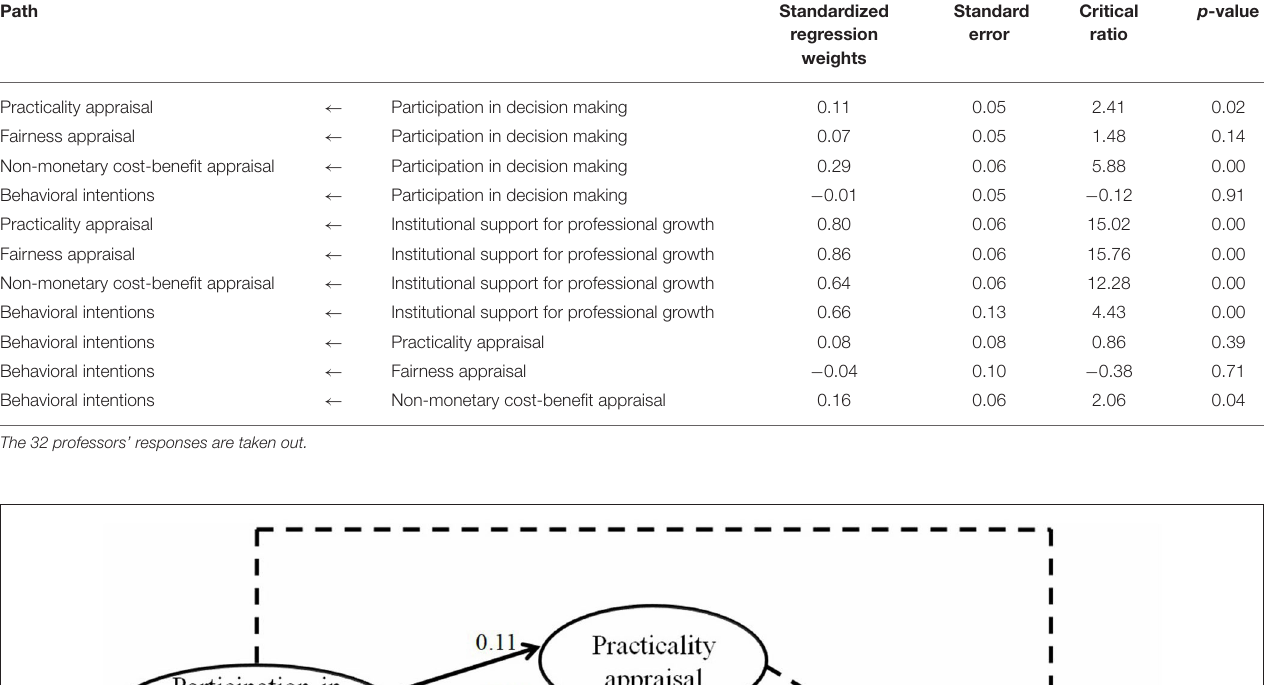
TABLE 5 | The direct effect of participation in decision-making and institutional support for professional growth on appraisal and behavioral intentions ( N = 340). Path Standardized